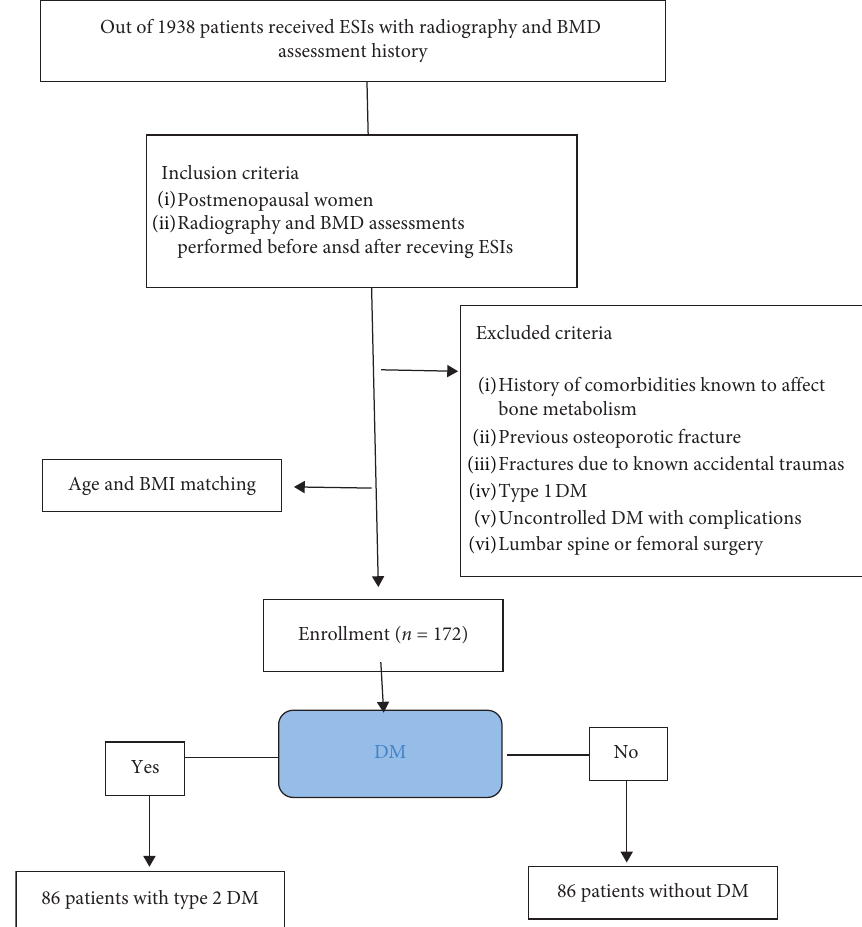
Figure 1: CONSORT flow diagram. Table 1: Baseline demographic and clinical